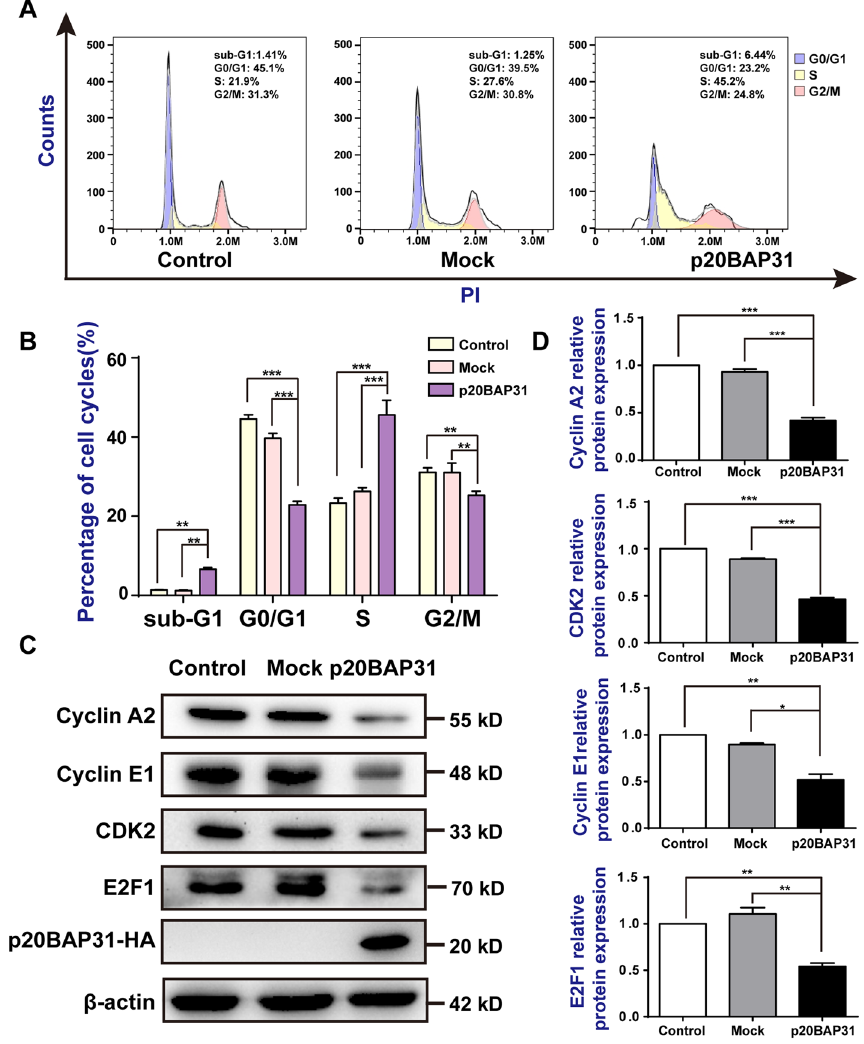
Fig. 2 p20BAP31 induced cell cycle arrest at S phase. A Flow cytometry was used to determine the cell cycle distribution of HCT116 cells transfected with p20BAP31 for 48 h. B Statistical analysis of the cell cycle distribution of HCT116 cells. C, D The expression levels of cyclin A2, cyclin E1, and CDK2 in HCT116 cells were measured by western blot analysis after transfection with p20BAP31 for 48 h. * P < 0.05, ** P < 0.01, *** P <